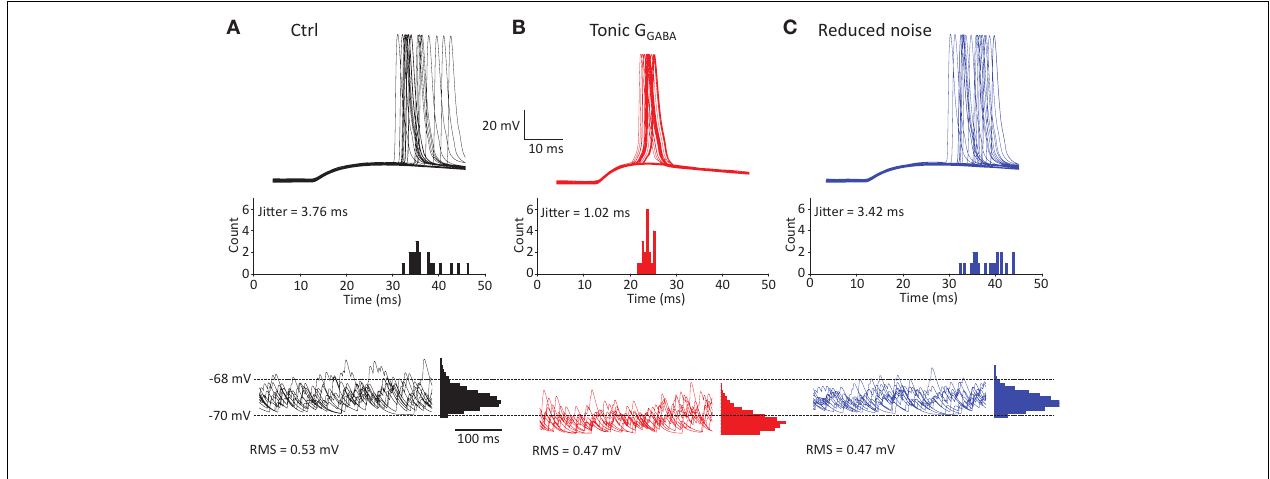
FIGURE 6 | Effect of tonic GABA A conductance on spike jitter in modeled CA1 pyramidal neuron. (A) Neuron received multisynaptic EPSP and background synaptic noise. The amplitude of EPSP was adjusted to obtain 50% spike success rate. Top , sample traces showing spike generation; Middle , histogram showing spike count at different